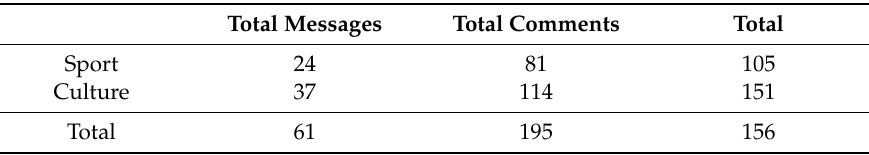
Table 5. Messages and comments on the Cadrete